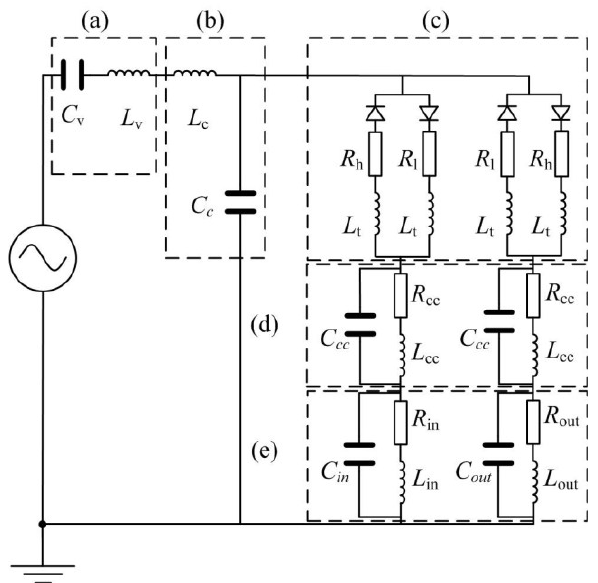
Figure 6. Equivalent circuit diagram of valveless piezoelectric pump with multistage Y-shape treelike bifurcate tubes: ( a ) Piezoelectric vibrator; ( b ) Pump chamber; ( c ) Multistage Y-shape treelike bifurcate tube; ( d ) Collection chamber; ( e ) Inlet/Outlet tube.